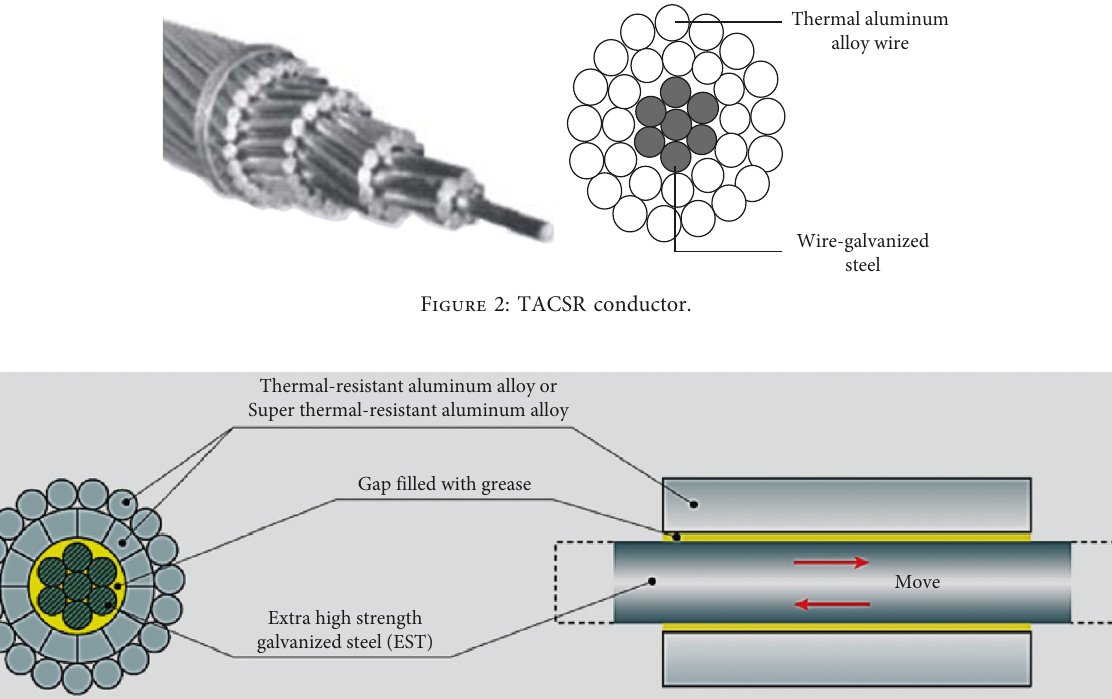
Figure 3: Gap-type conductor.